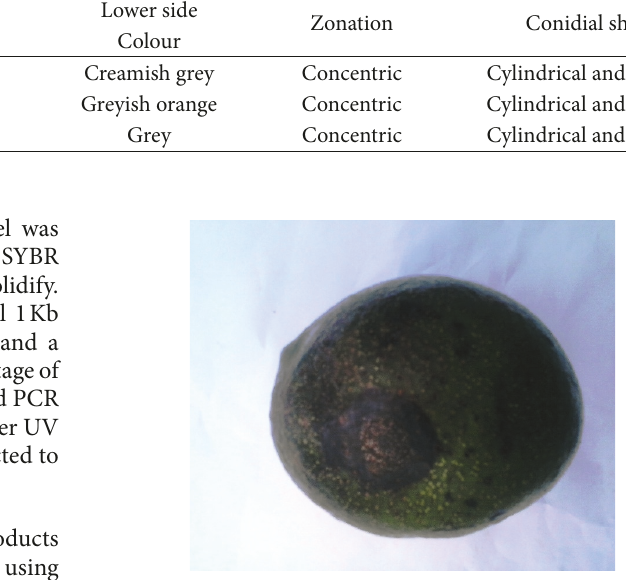
Figure 1: Anthracnose symptoms on avocado